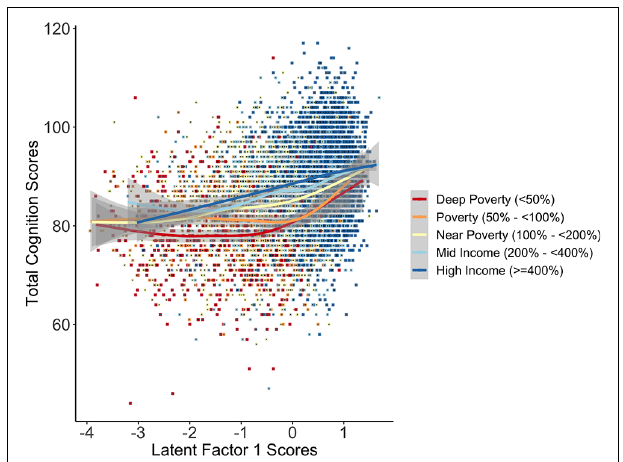
FIGURE 5 | The plot of the interaction of the INR by LF1 scores in association with total cognition scores shows differences in total cognition scores between income-to-need groups varied as a function of LF1 scores. While total cognition scores steadily increased with higher LF1 scores for children with higher SES (mid to high income), total cognition scores for children in poverty and deep poverty showed a protracted shift in scores, revealing an advantage in total cognition scores for children from higher SES households in the middle-range of LF1 scores. Importantly, the gap in total cognition scores between low SES and higher SES narrowed for children at two intersections with latent factor scores: those with higher (approx. +2) scores (i.e., a higher endorsement of access to resources relative to the lower endorsement of adversity) and those with lower (approx. − 3) scores (i.e., fewer resources relative to higher